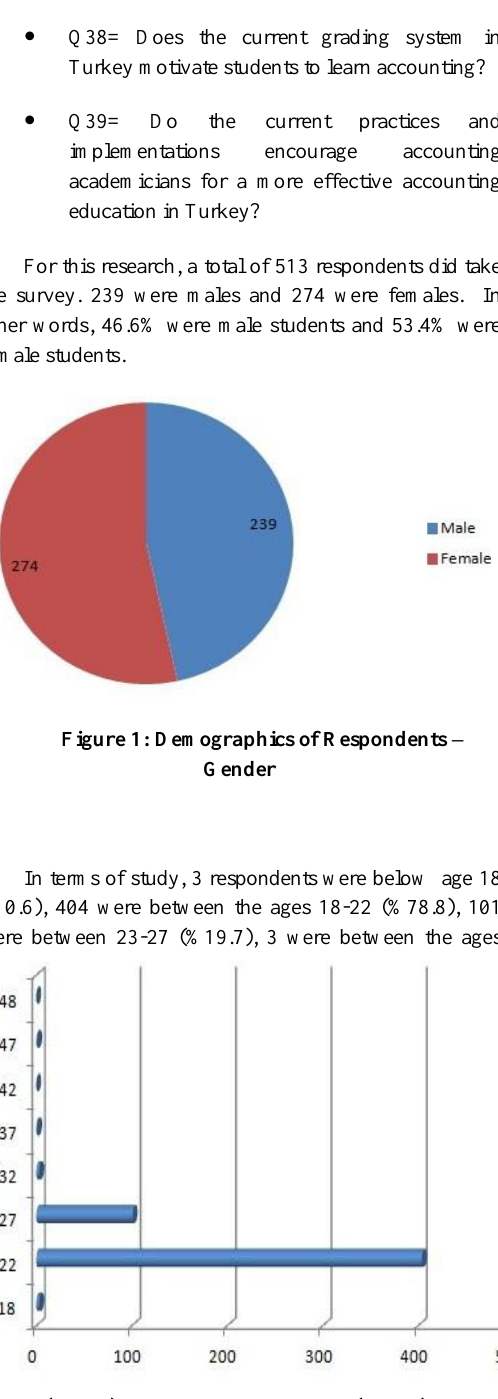
between the ages 43-47 (%0.02). Figure 2: Demographics of Respondents –